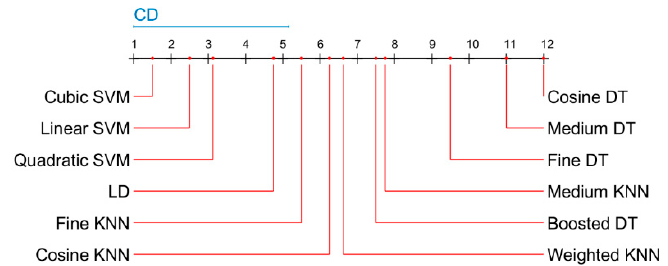
Figure 14. Critical di ff erence diagram of the Nemenyi test results for malware classification using a Figure 14. Critical difference diagram of the Nemenyi test results for malware classification using a fusion of SFTA and pre-trained neural network features (balanced dataset). CD is critical di ff fusion of SFTA and pre-trained neural network features (balanced dataset). CD is critical difference. Figure 14. Critical difference diagram of the Nemenyi test results for malware classification using a Figure 14. Critical difference diagram of the Nemenyi test results for malware classification using a fusion of SFTA and pre-trained neural network features (balanced dataset). CD is critical difference. fusion of SFTA and pre-trained neural network features (balanced dataset). CD is critical difference.